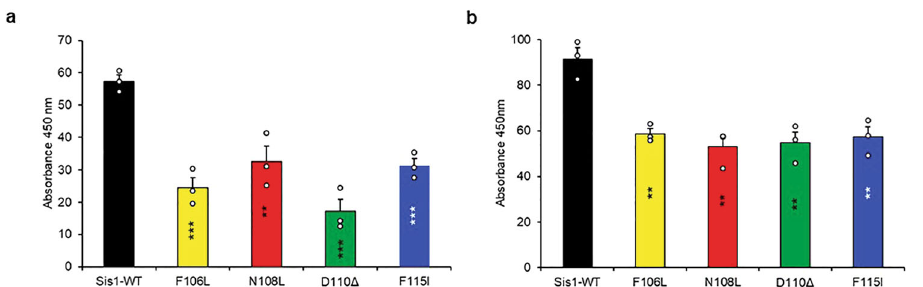
Fig. 5 | LGMDD1 G/F domain mutants showed reduced dimerization. a For homodimerization, uncleaved His-tagged Sis1-WT and mutants (20nM) were added into non-His-tagged (cleaved) Sis1-WT and mutants (200nM) and adsorbed in microtiter plate wells. b For heterodimerization, uncleaved His-tagged Sis1-WT (20nM) was added to cleaved mutants (200nM) and adsorbed in microtiter plate wells. In both a , b , following adsorption, ELISA was performed using an anti-His